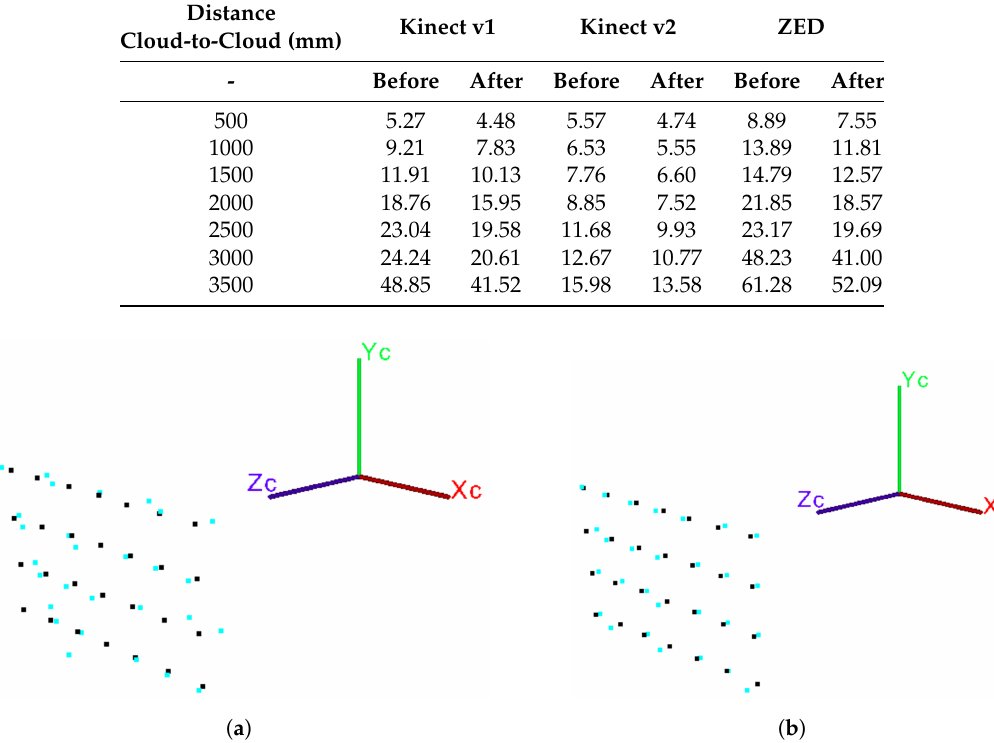
Figure 8. Registration example of two point clouds with known correspondences (captured with the Kinect v1), ( a ) before and ( b ) after correction. The source point cloud (black) is captured at 0.5 m and the target cloud (cyan) is taken at 4 m away from the